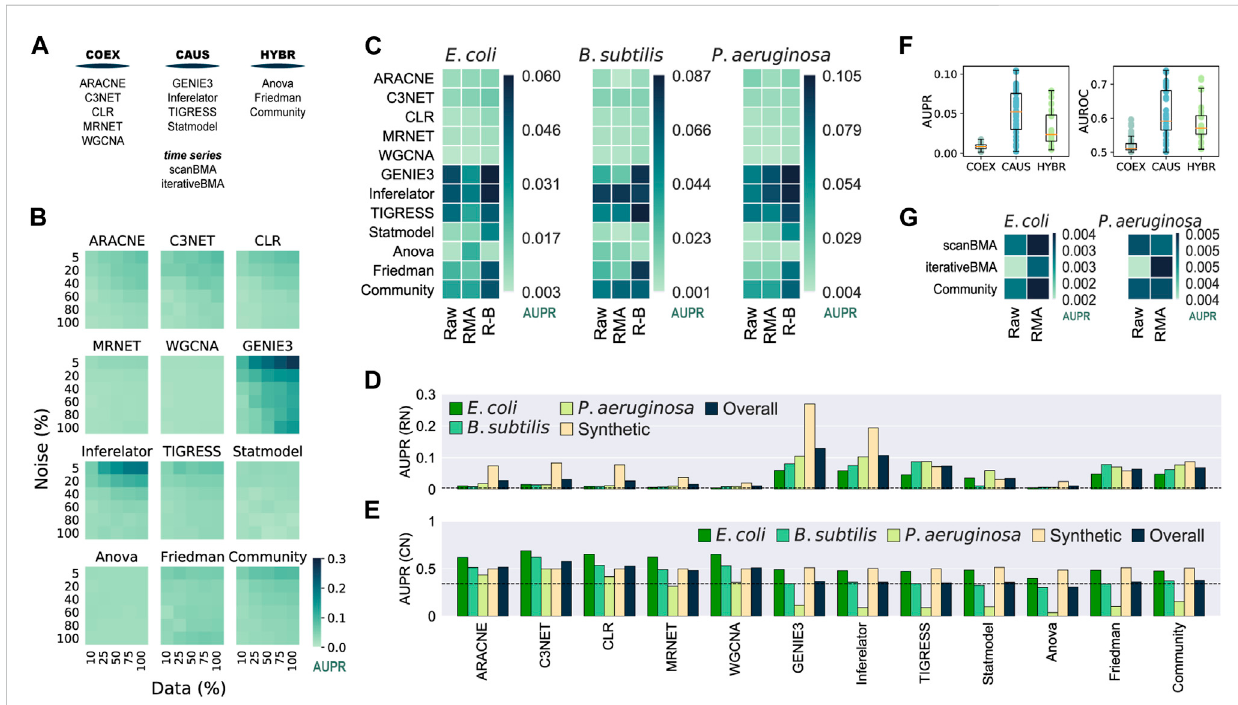
FIGURE 2 Assessment of network inference tools for microarray data. 100% of the synthetic dataset contains a total of 788 conditions. The Community Network is the integration of the single-tool predictions using the Borda count method (Marbach et al., 2012). (A) Network classi fi cation. Network inference tools for microarray data were classi fi ed according to the type of network they infer. (B) GENIE3 is the best tool for synthetic data. Synthetic gene expression datasets with different levels of noise and completeness were generated from the biological network of E. coli (511145_v2017_ sRDB16_eStrong).ThesamenetworkwasusedastheGSfortheassessment. (C) Batchcorrectionandknowledgeofthetranscriptionfactorsimprovethe inference oftranscriptional GRNs.CausalandHybridtoolsoutperformedCo-expression toolsintheassessment ofGRNsusing biological datafor E.coli , B. subtilis, and P. aeruginosa with different levels of data normalization: raw data, Robust Multiarray Averaging (RMA), and RMA plus batch correction. Inferences were assessed with experimentally-validated GRNs. (D) GENIE3 is the best tool for the inference of GRNs. (E) Assessment for the inference of co-regulation network.TheCOEXtoolsoutperformedCAUSandHYBRtools.C3NETperformedthebest. (F) Boxplot representation ofdatainpanel Cto highlight the differences across tool groups. (G) scanBMA outperformed iterativeBMA with biological data. The Community network for this panel only integrates interactions from scanBMA and iterativeBMA.